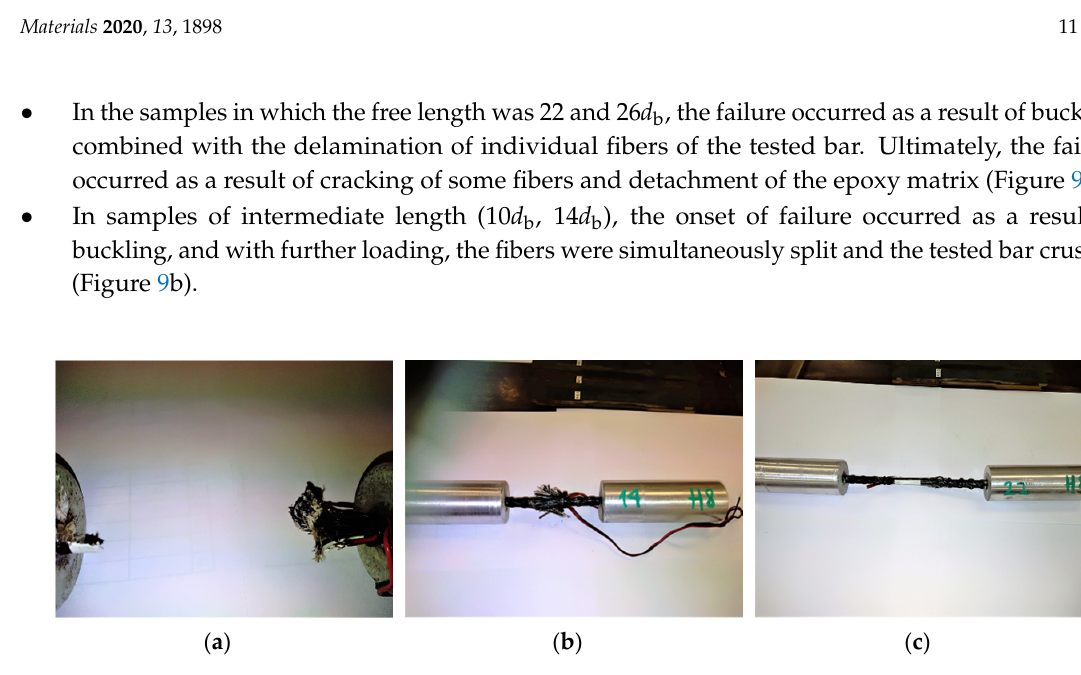
Table 2. Comparison of compression and tension characteristics of HFRP bars (absolute value).